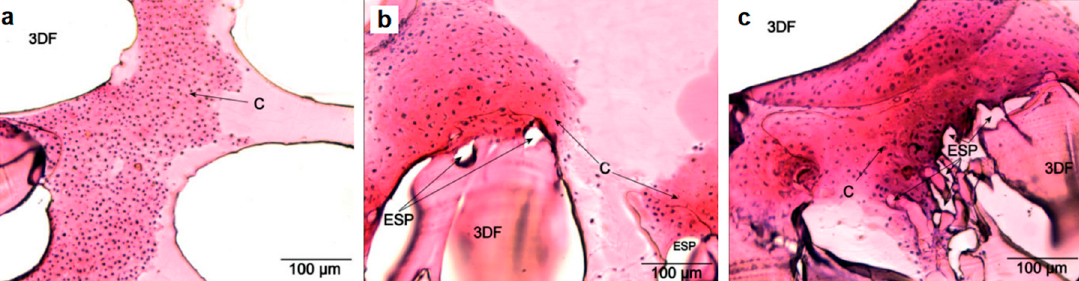
Figure 4. Histological cross-sections show sulphated GAG formation in ( a ) 3DF, ( b ) 3DFESP-30, and ( c ) 3DFESP-2 scaffolds by safranin-O staining. C indicates cartilage formation (GAG), 3DF refers to the macro fibers, and ESP refers to the microfibers. Reproduced with permission from C. A. van Blitterswijk et al., Advanced Functional Materials; published by John Wiley and Sons, 2007 [74].